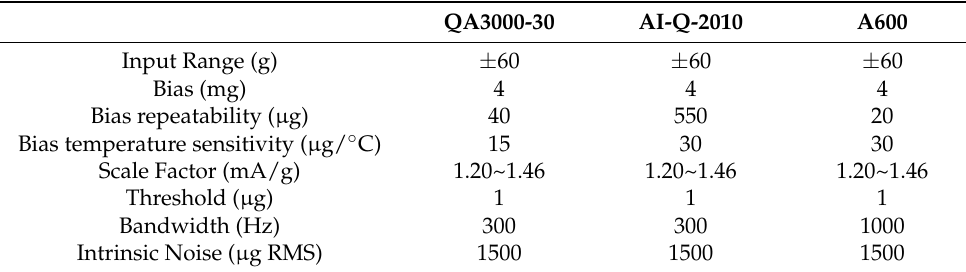
Table 1. Main performance characteristics of QA3000-300, AI-Q-2010 and